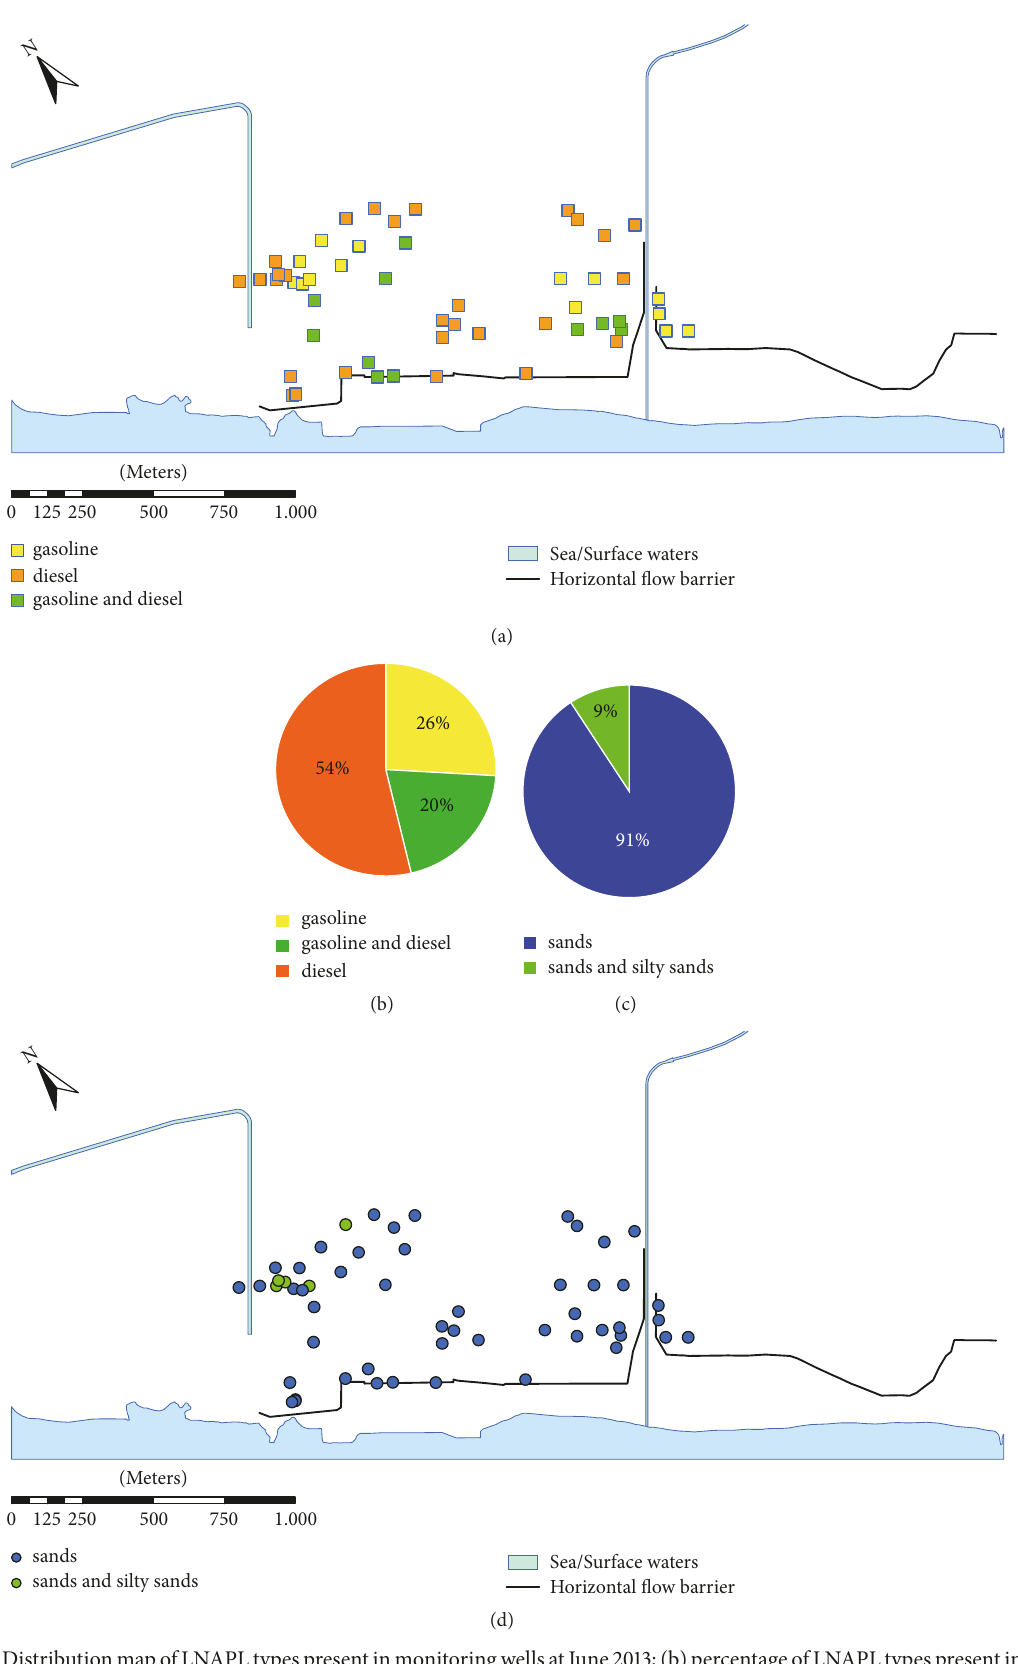
Figure2:(a)DistributionmapofLNAPLtypespresentinmonitoringwellsatJune2013;(b)percentageofLNAPLtypespresentinmonitoring wells at June 2013; (c) percentage of different soil types found in the contaminated monitoring wells; (d) distribution map of soil type found in the contaminated monitoring